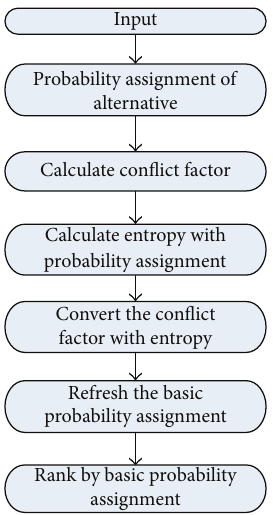
Figure 2: The flowchart of the improved